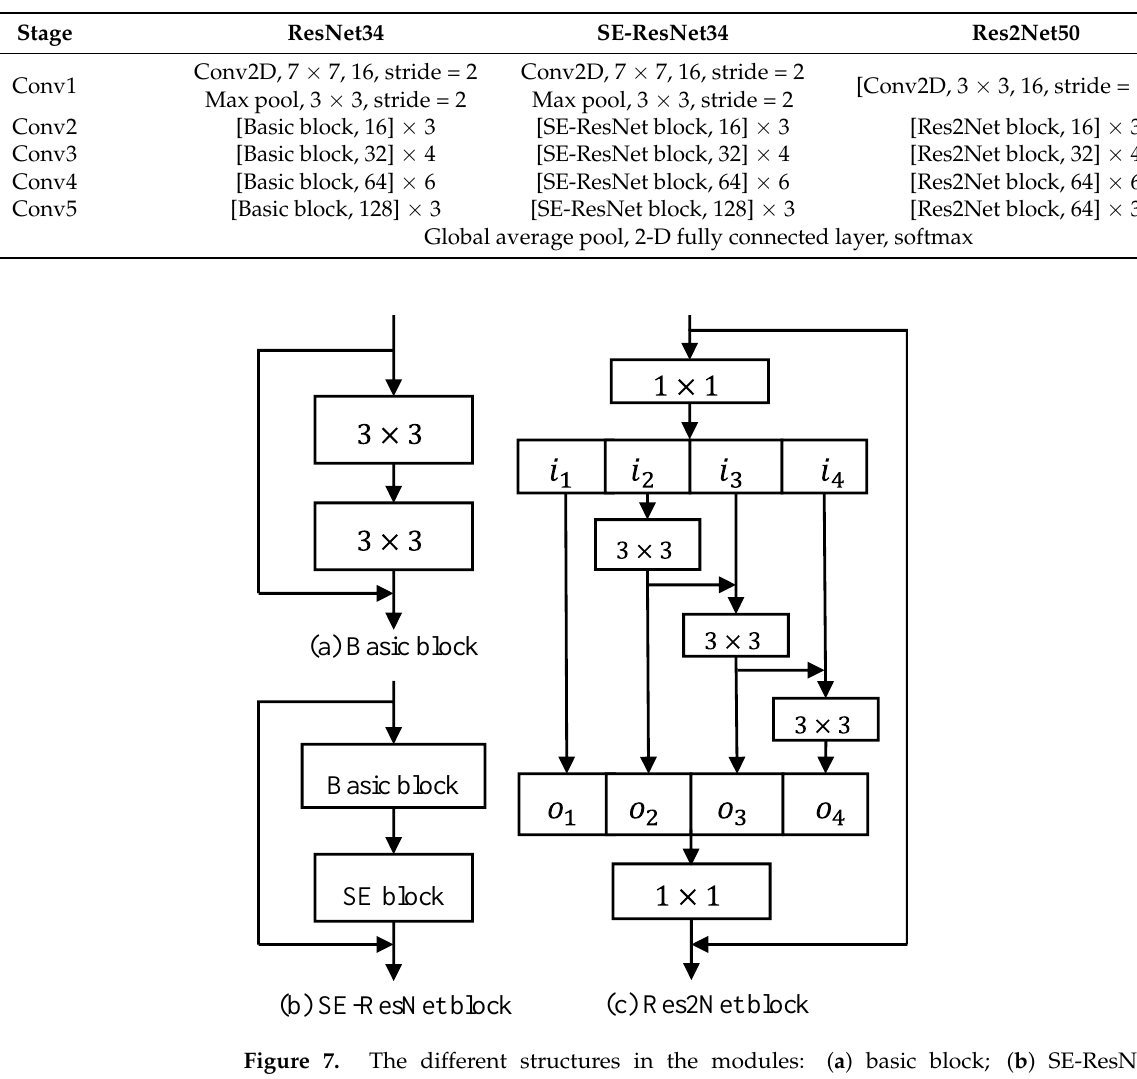
Figure 7. The different structures in the modules: ( a ) basic block; ( b ) SE-ResNet block; ( c ) Res2Net